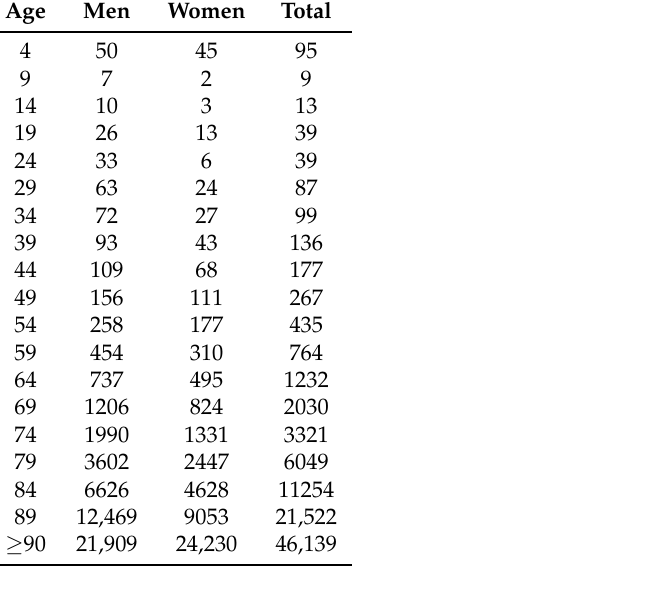
Table 1. Norwegian mortality in 2018, per 100,000 inhabitants. Data from Statistics Norway, table: 05381. Age Men